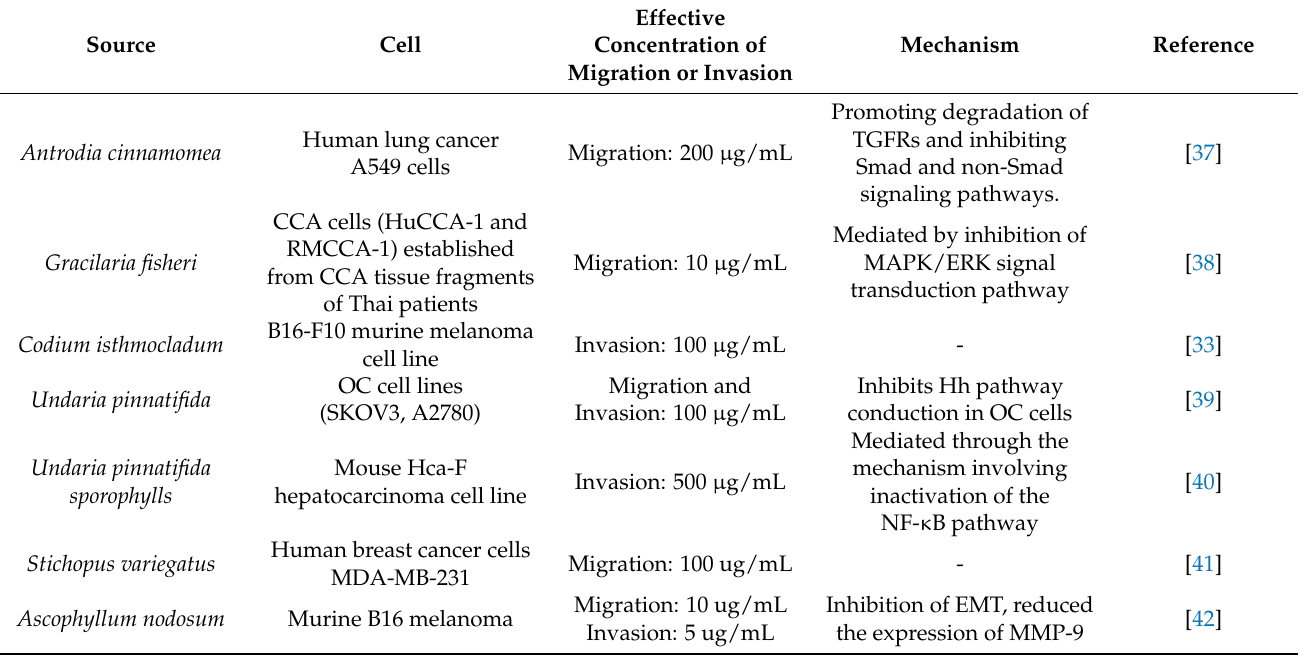
Table 2. Effects of sulfated polysaccharides from different sources on migration and